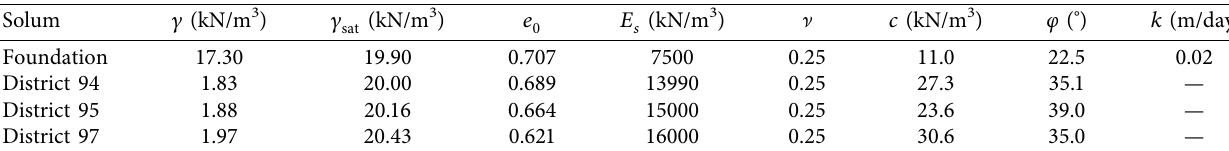
Table 2: Calculation parameters of foundation and subgrade.